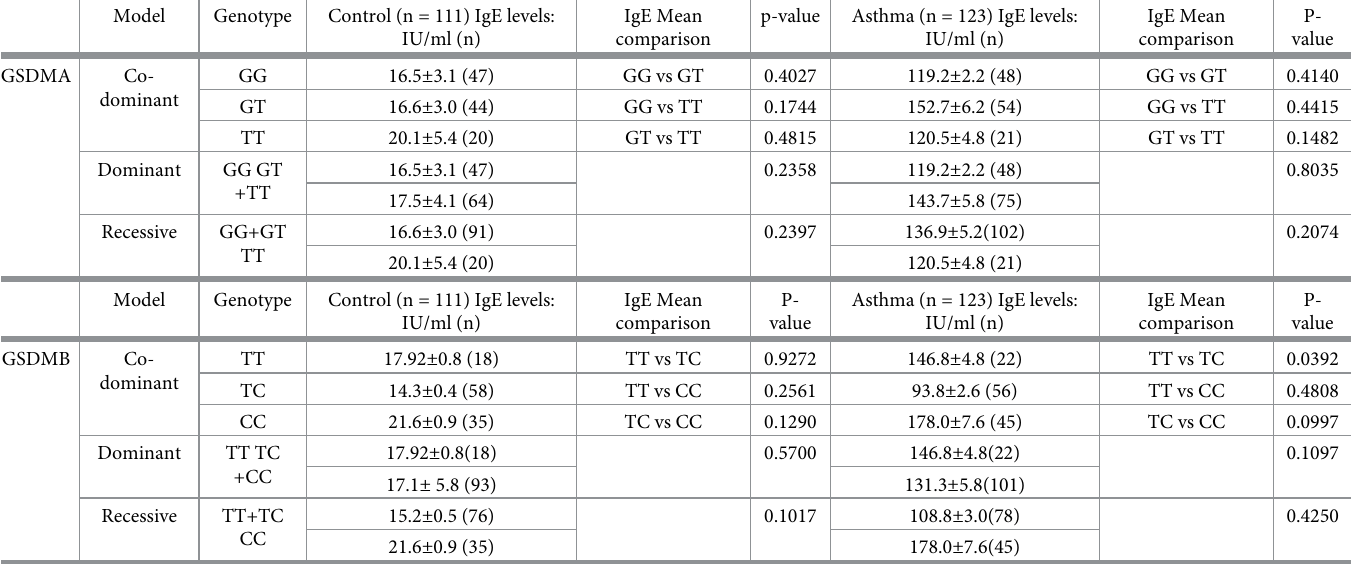
Table 3. Comparison between IgE levels of adult asthma patients and control group according to GSDMA and GSDMB.